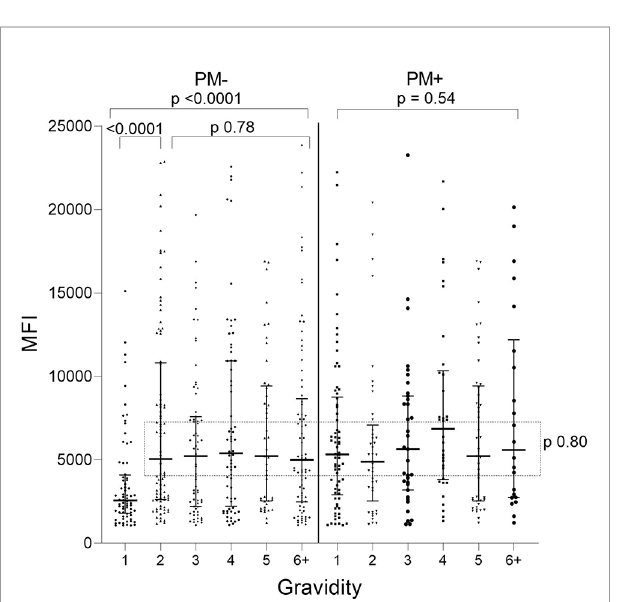
FIGURE 1 | Antibody levels to full-length FV2 at delivery in different gravidity groups. A signi fi cant difference in median Ab levels was detected among the six gravidity (G) groups (Kruskal-Wallis test: p = 0.002). Post hoc pairwise comparison showed that primigravidae (G1) had signi fi cantly lower Ab levels to FV2 than each of the other gravidity groups. Ab levels among groups shown in the rectangle did not differ signi fi cantly (Kruskal-Wallis test: p = 0.57). n = 644 women and 20 males (replicates shown, n=40 data points). Horizontal lines represent medians and